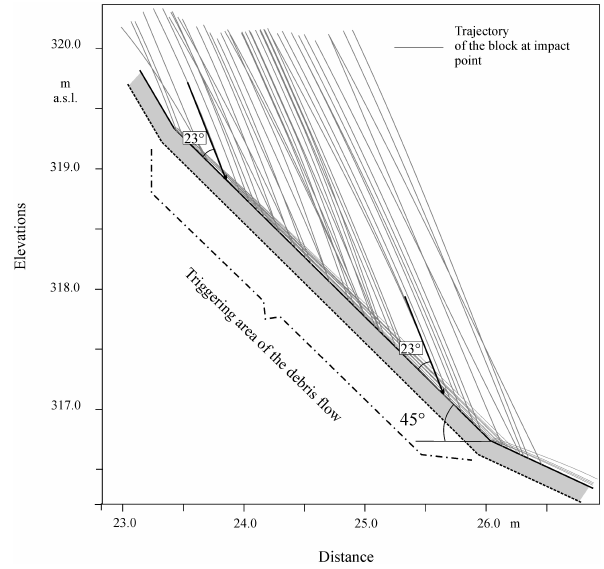
Fig. 11. Details of trajectories of landing and sliding simulated blocks, along a topographical profile passing through the landslide crown